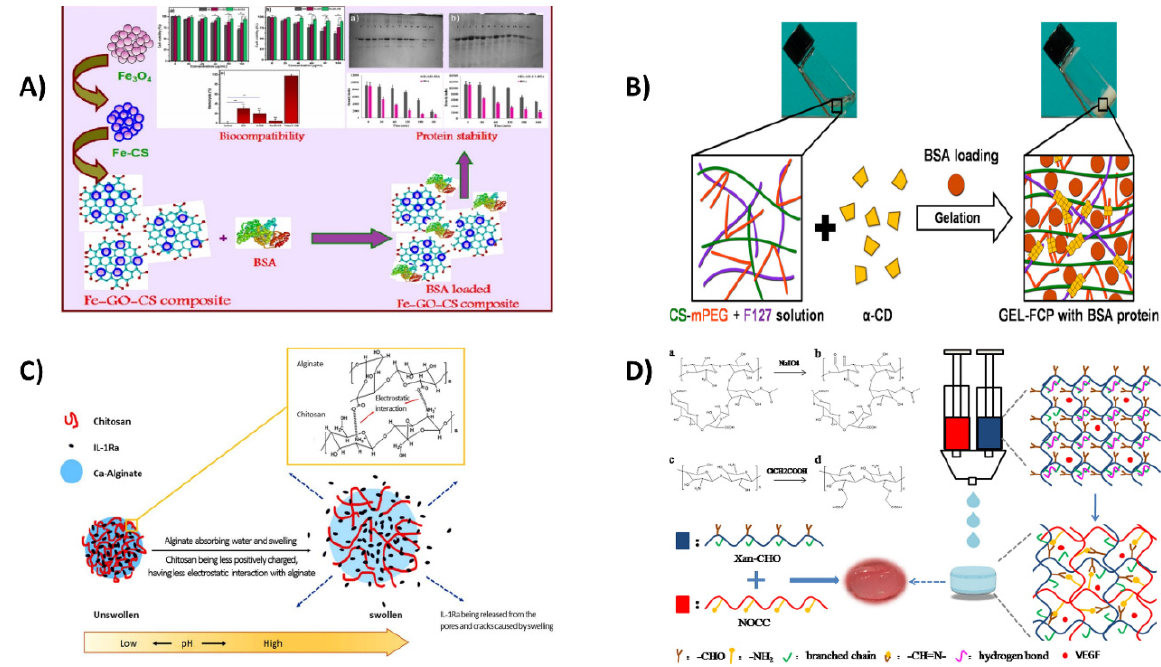
Figure 3. ( A ) A graphene oxide–chitosan combination with magnetic nanoparticles as a protein- delivering vehicle. Reproduced with permission from [141], copyright Elsevier 2021. ( B ) Fabrication of Chitosan–PEG conjugates and its Supramolecular Hydrogels for Protein Delivery Using Sulfur (VI) Fluoride Exchange (SuFEx) [144] ( C ) In situ application of the protein interleukin-1 receptor antagonist (IL-1Ra) for the therapy of dextran sulfate sodium (DSS)-induced colitis in a murine